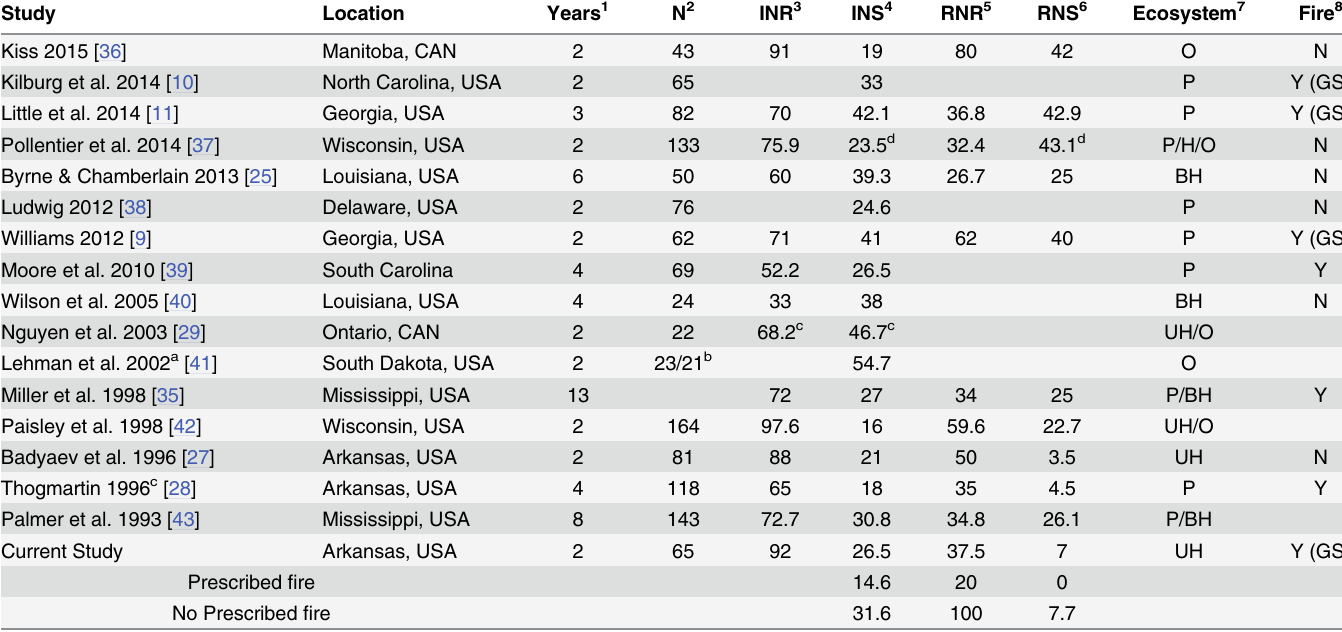
Table 1. Comparison of eastern wild turkey ( Meleagris gallopavo silvestris ) reproductive parameters from across the sub-species' North American Range.